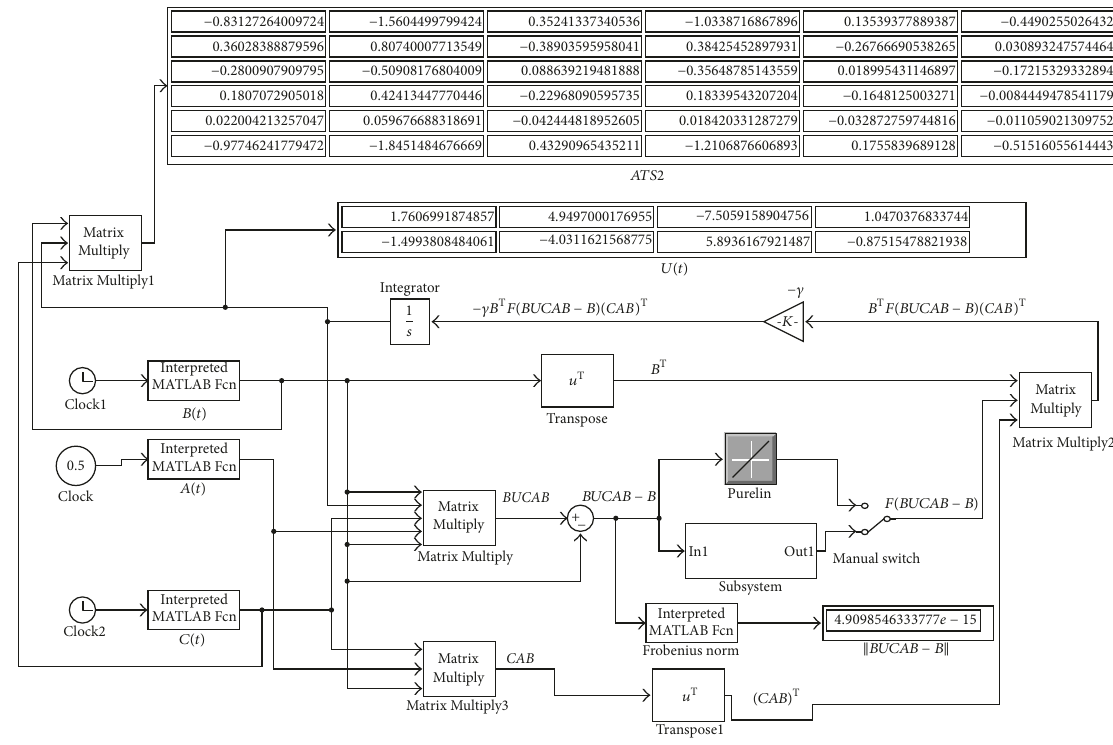
Figure 2: GGNN model for computing 𝐵(𝑡)𝑈(𝑡)𝐶(𝑡)𝐴(𝑡)𝐵(𝑡) = 𝐵(𝑡) , 𝑋(𝑡) = 𝐵(𝑡)𝑈(𝑡)𝐶(𝑡)